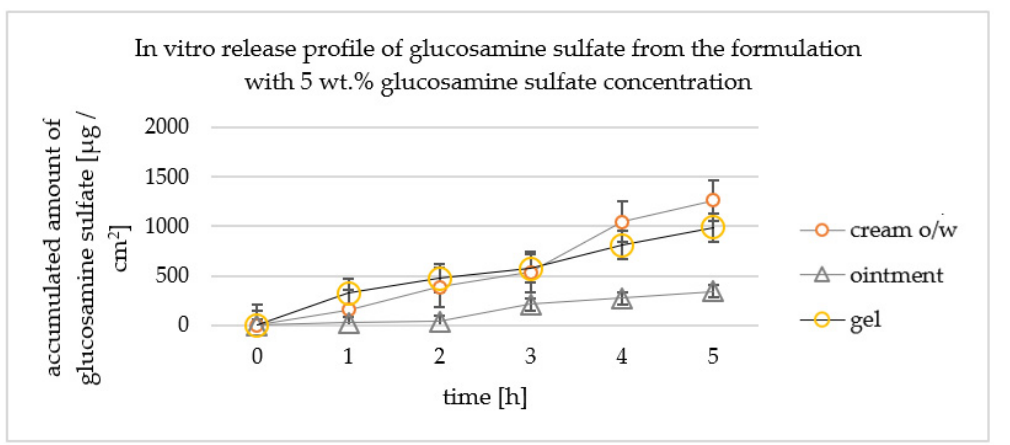
Figure 4. Accumulated amount of glucosamine sulfate—in vitro release study for 5 wt.% formula- tion.